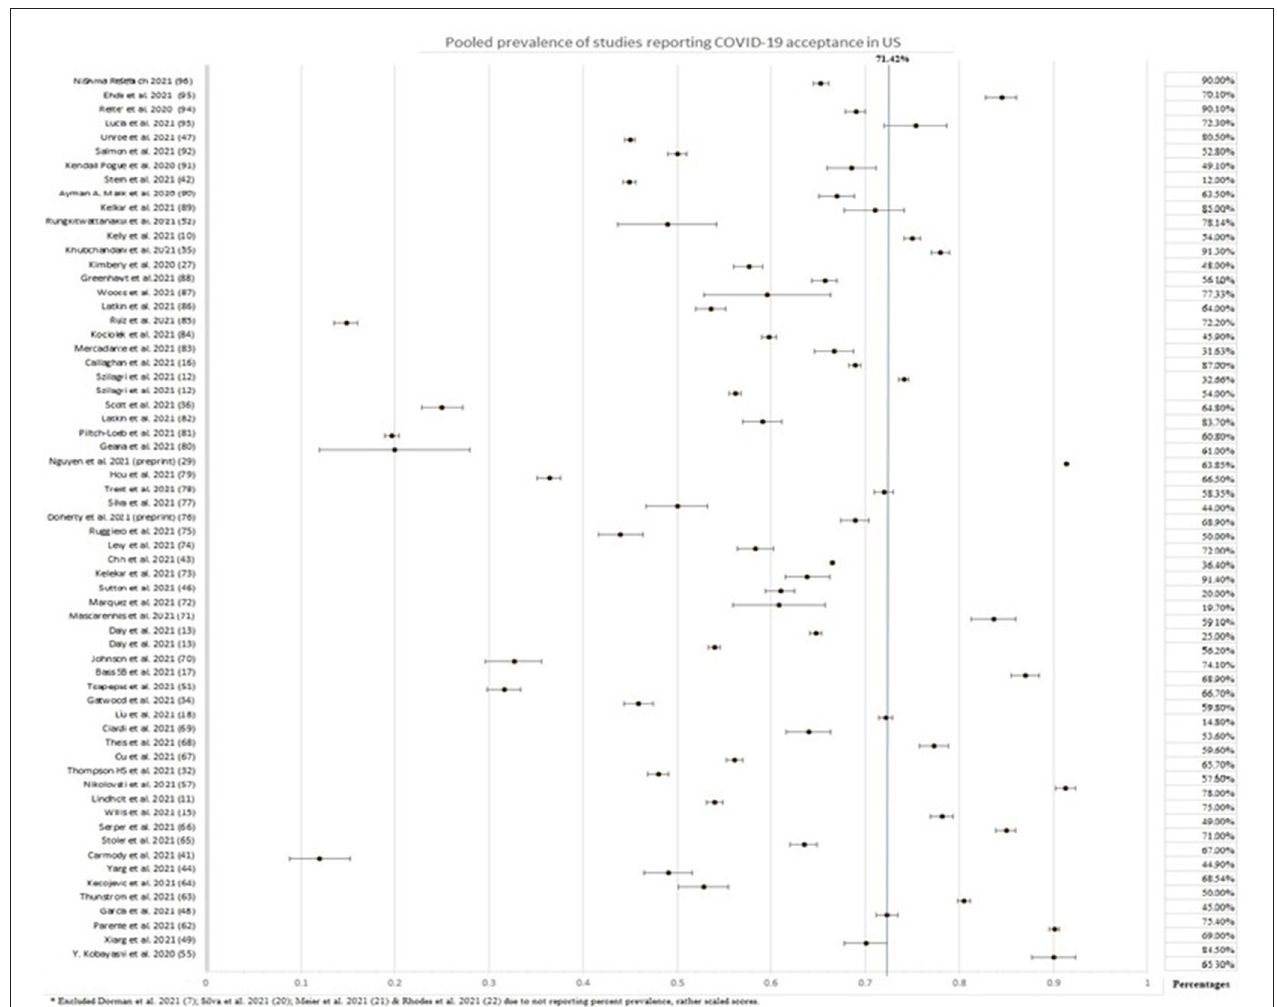
FIGURE 4 | Pooled prevalence of COVID-19 vaccine acceptance in the United